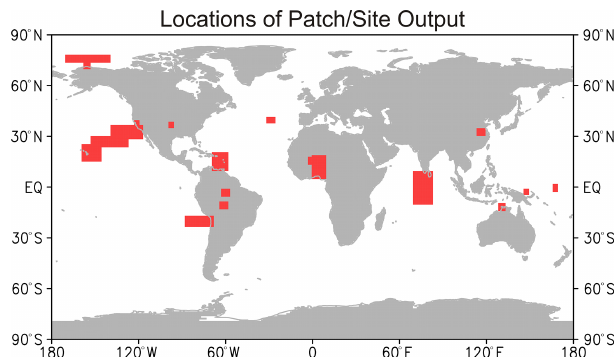
Figure 2. Locations of model patch/site output associated with ma- jor field campaigns or US Department of Energy Atmospheric Radi- ation Measurement (ARM) sites. See Table 1 for detailed longitude and latitude information. Table 1. Locations of model patch/site output associated with major field campaigns or DOE ARM